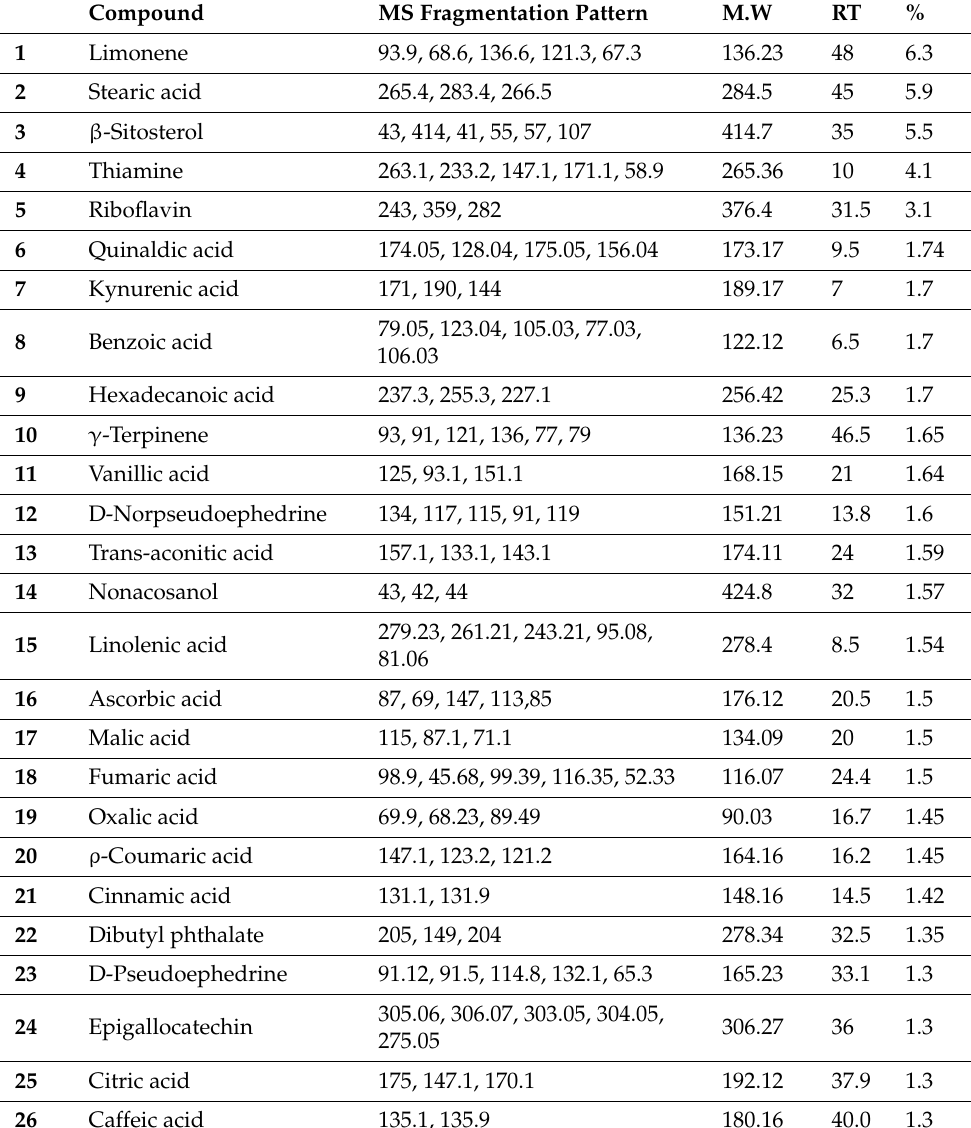
Table 2. Terpenes, organic acids and other contents identified in Ephedra foeminea aqueous extract using